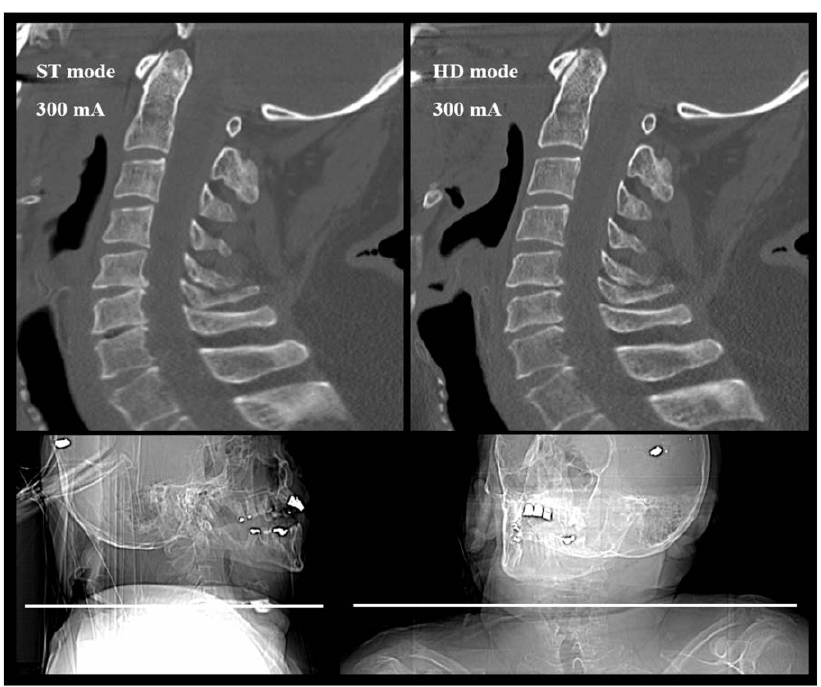
Figure 1. Image quality of the upper c-spine (C1–C4) is diagnostic regardless of all body parameters with protocol VI at 20 mAs. In this cadaver (BMI of 30.9 kg/m 2 , an anteroposterior diameter of 26 cm and high shoulder position), diagnostic images of the lower c-spine were acquired at 300 mAs with tube current modulation corresponding to a CTDI of 15.93 mGy and an effective dose of 1.59 mSv. Associated topograms of the same cadaver are shown in Figure 2.